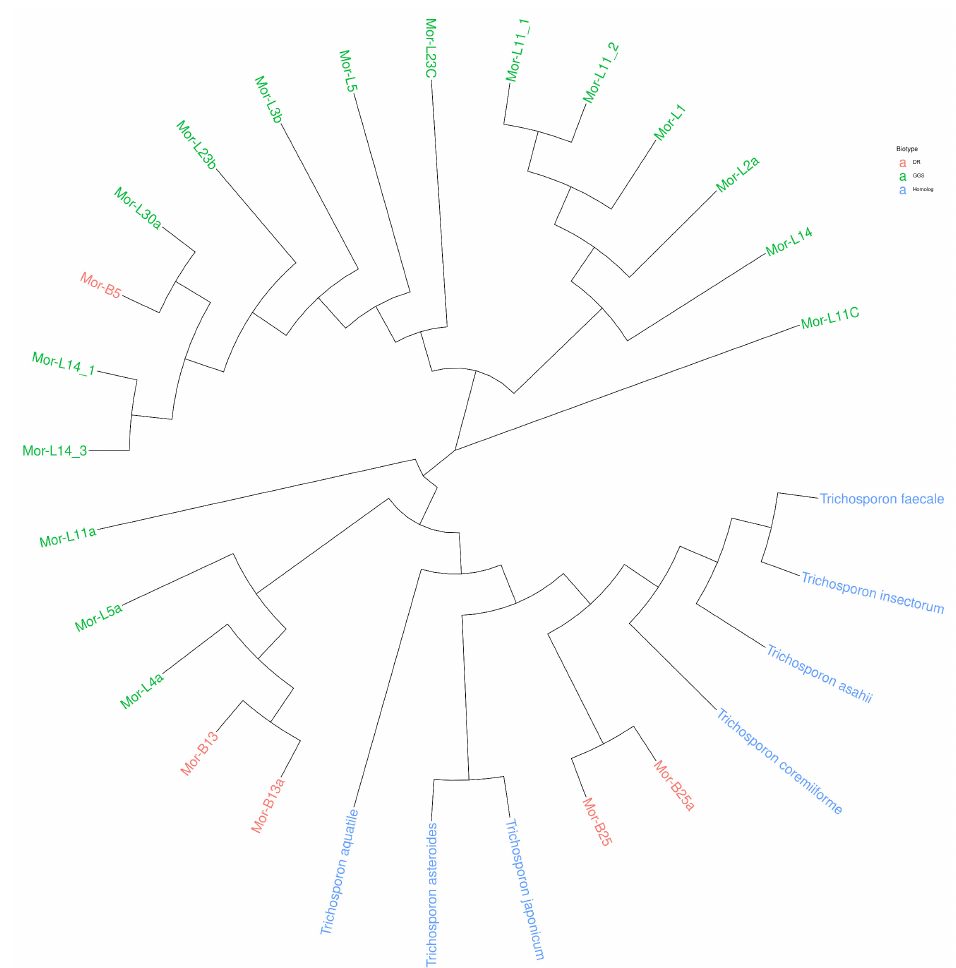
Figure 9. Phylogenetic tree of all the strains with their top BLAST hits.